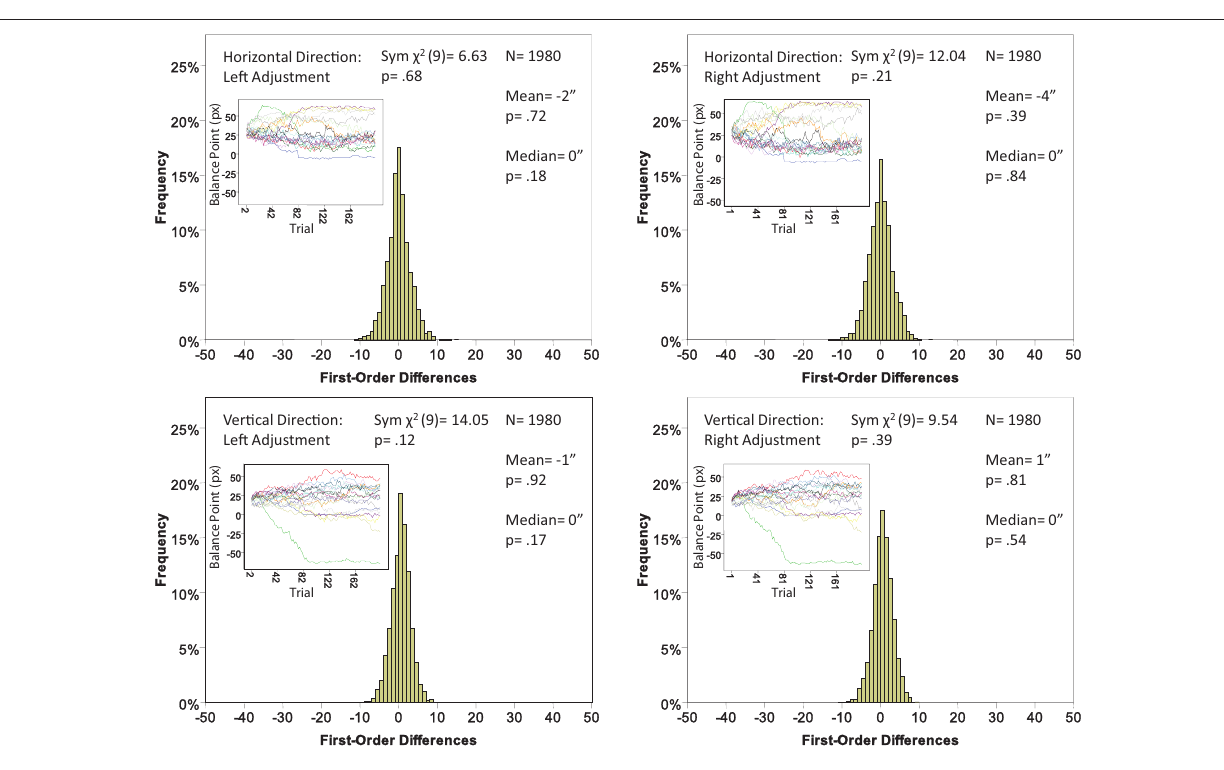
Figure 10 | Histograms of the ∆ ’s for the location experiment, participant P3. The rest as in Figure